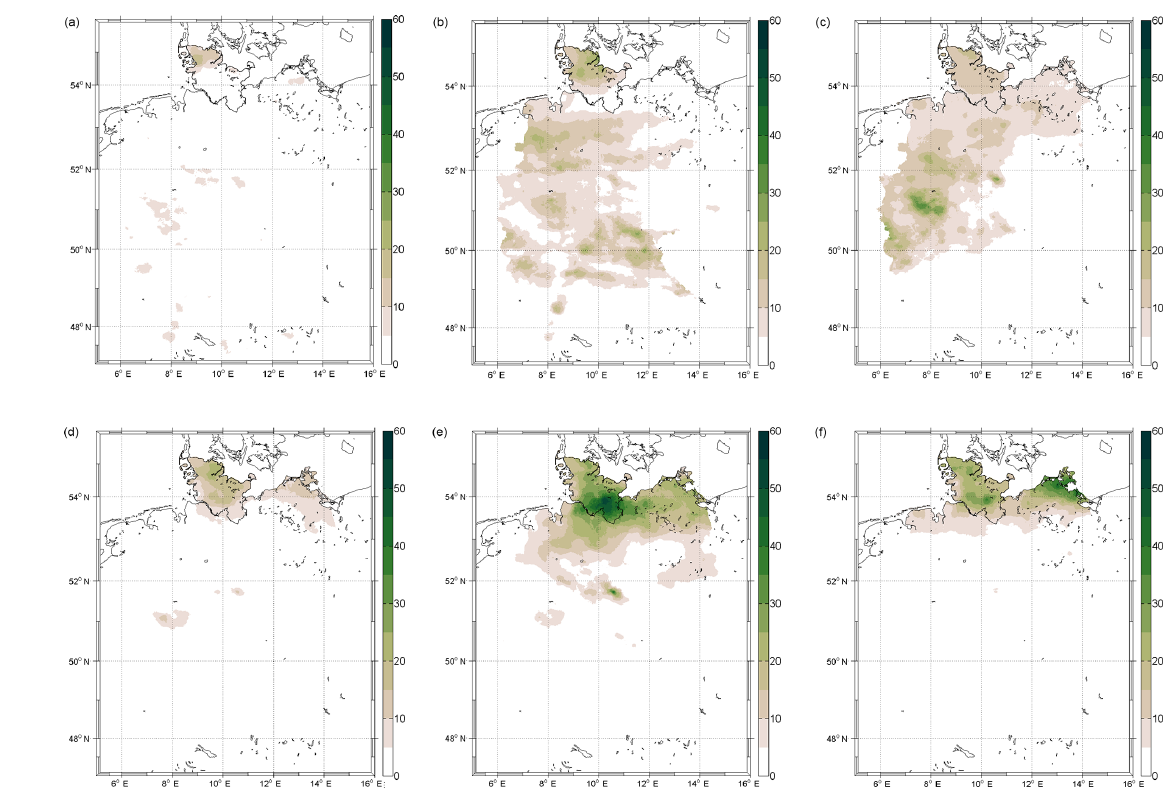
Figure 4. Daily sums of REGNIE precipitation data in millimetres for the first event, 10–12 December 2014 (a–c) , and the main precipitation event, 21–23 December 2014 (d–f) . The boundaries of Schleswig-Holstein are marked in black.